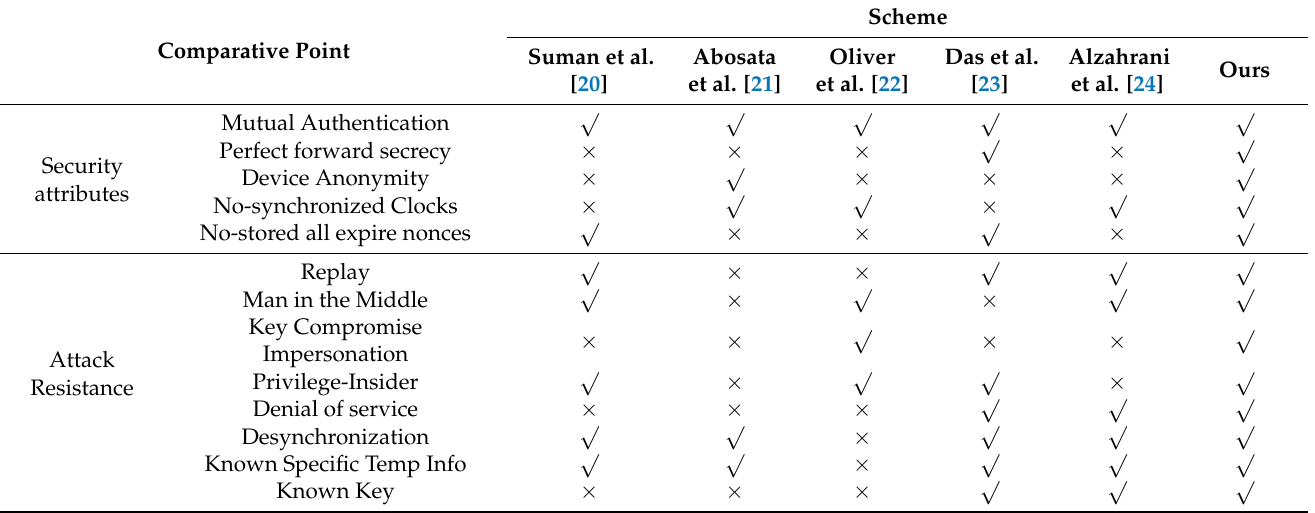
Table 8. Security attributes and attack-resistant comparison with similar